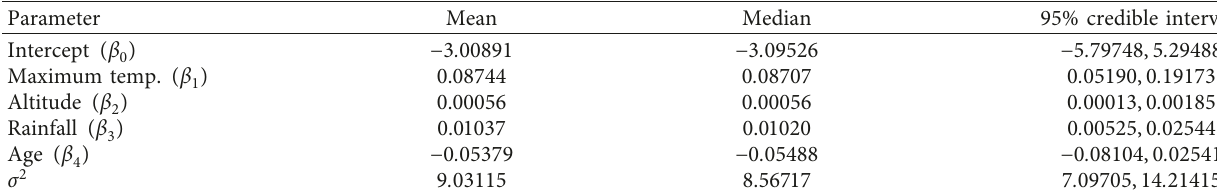
Figure 7: Posterior distribution of the model parameters. Table 3: Credible intervals of the intercept and covariates of the saturated model.